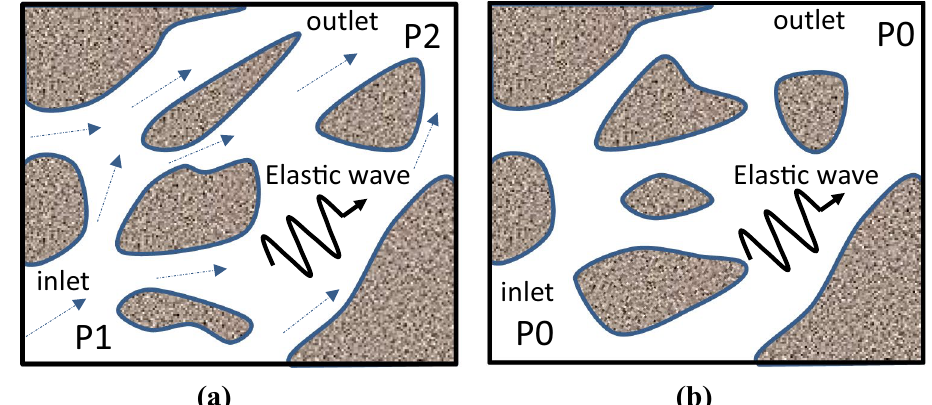
Fig. 1 Porous media saturated with the initial percolating fluid ( a ) and static fluid ( b